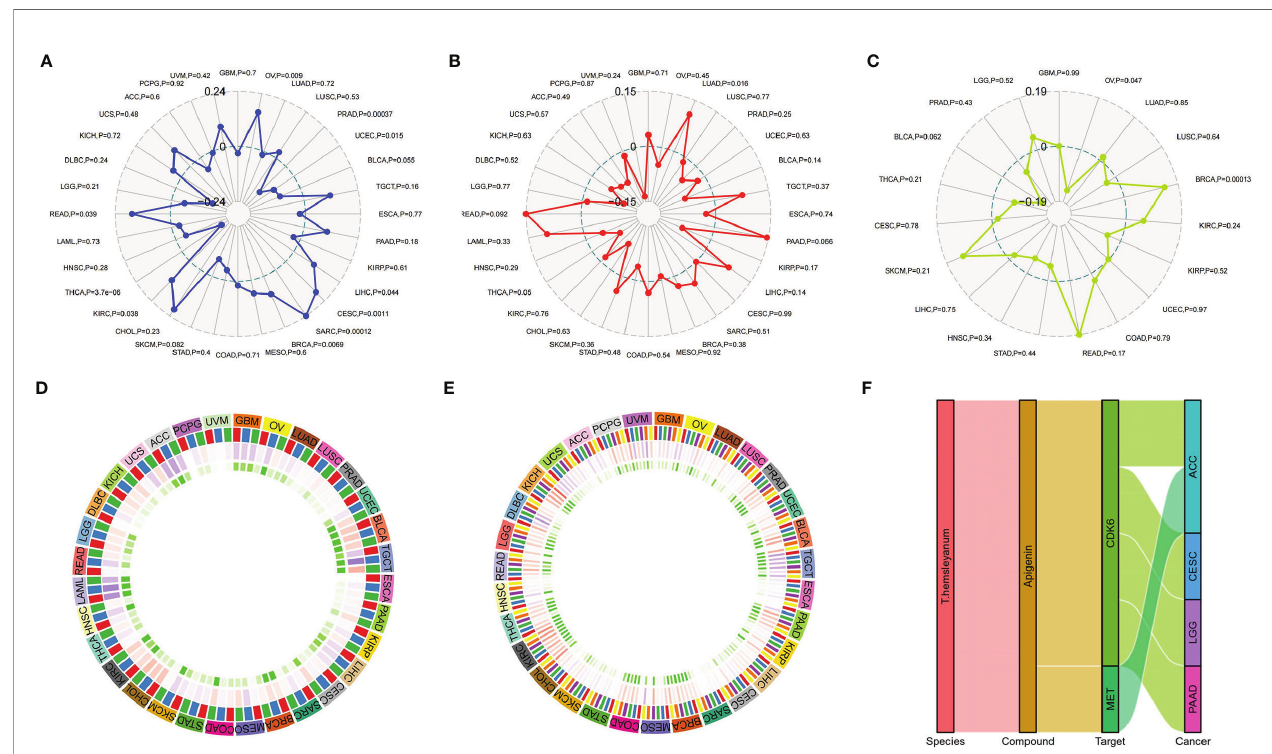
FIGURE 8 | Correlation of T. hemsleyanum -targeted protein CDK6 with immunity and mutation in pan-cancer. (A) Correlation analysis of microsatellite instability. (B) Correlation analysis of TMB. (C) Correlation analysis of tumor neoantigens. (D) Correlation analysis of immune microenvironment. (E) Correlation analysis of tumor immune cell in fi ltration in pan-cancer. (F) Sanky plot of antitumor activity of T.